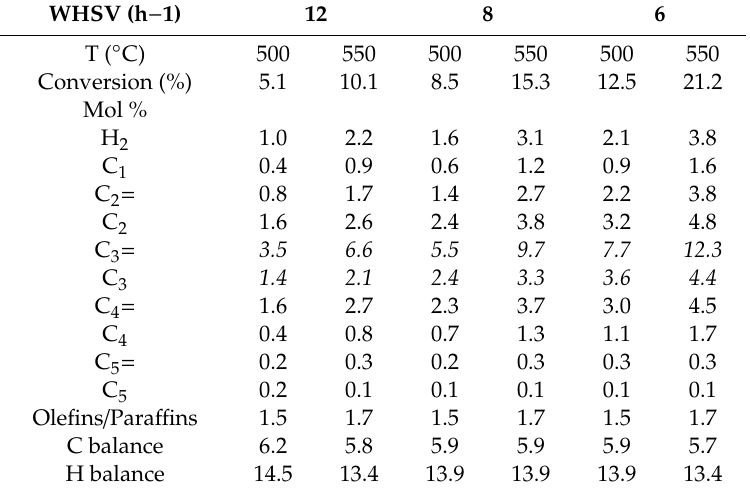
Table 1. Comparison of experimental results from fixed bed reactor recorded at di ff erent weighted hourly space velocity (WHSV) and